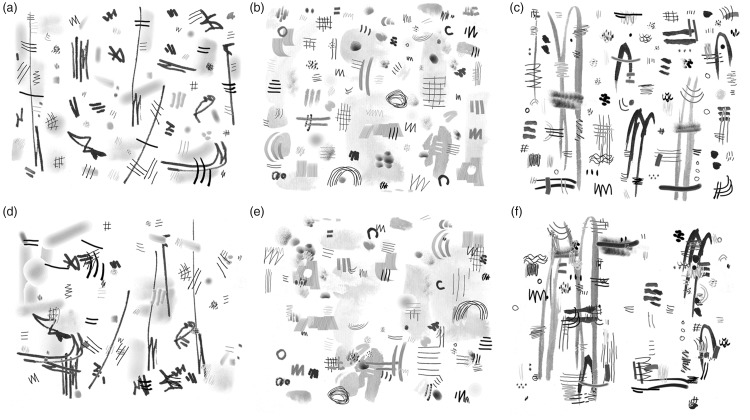
Examples of the stimuli used in the experiment. The pictorial elements of the original images (a–c) were shuffled to create images that lack an artistic composition (d–f). Reproduced with permission. © Christoph Redies, 2017.